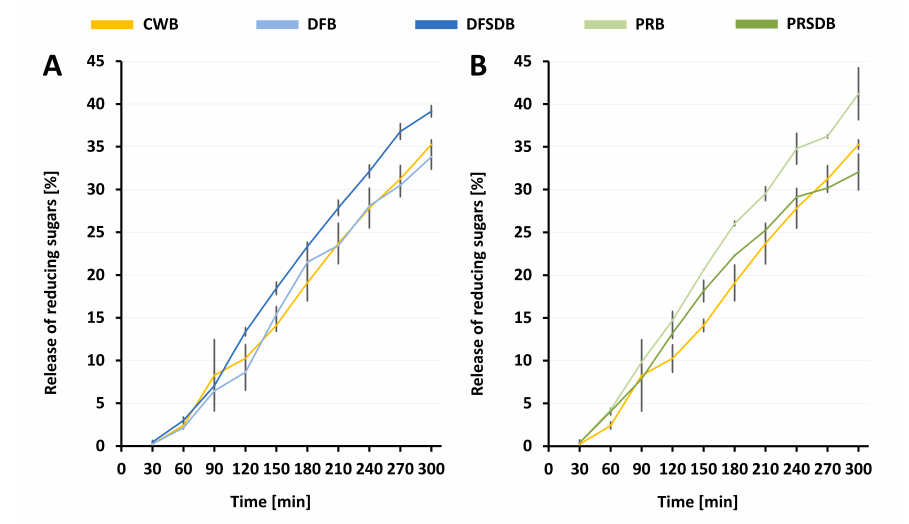
Figure 4. Sugar release curves expressed as reducing sugars as percentage of digestible starch: ( A ) DFB and DFSDB compared to CWB; ( B ) PRB and PRSDB compared to CWB.